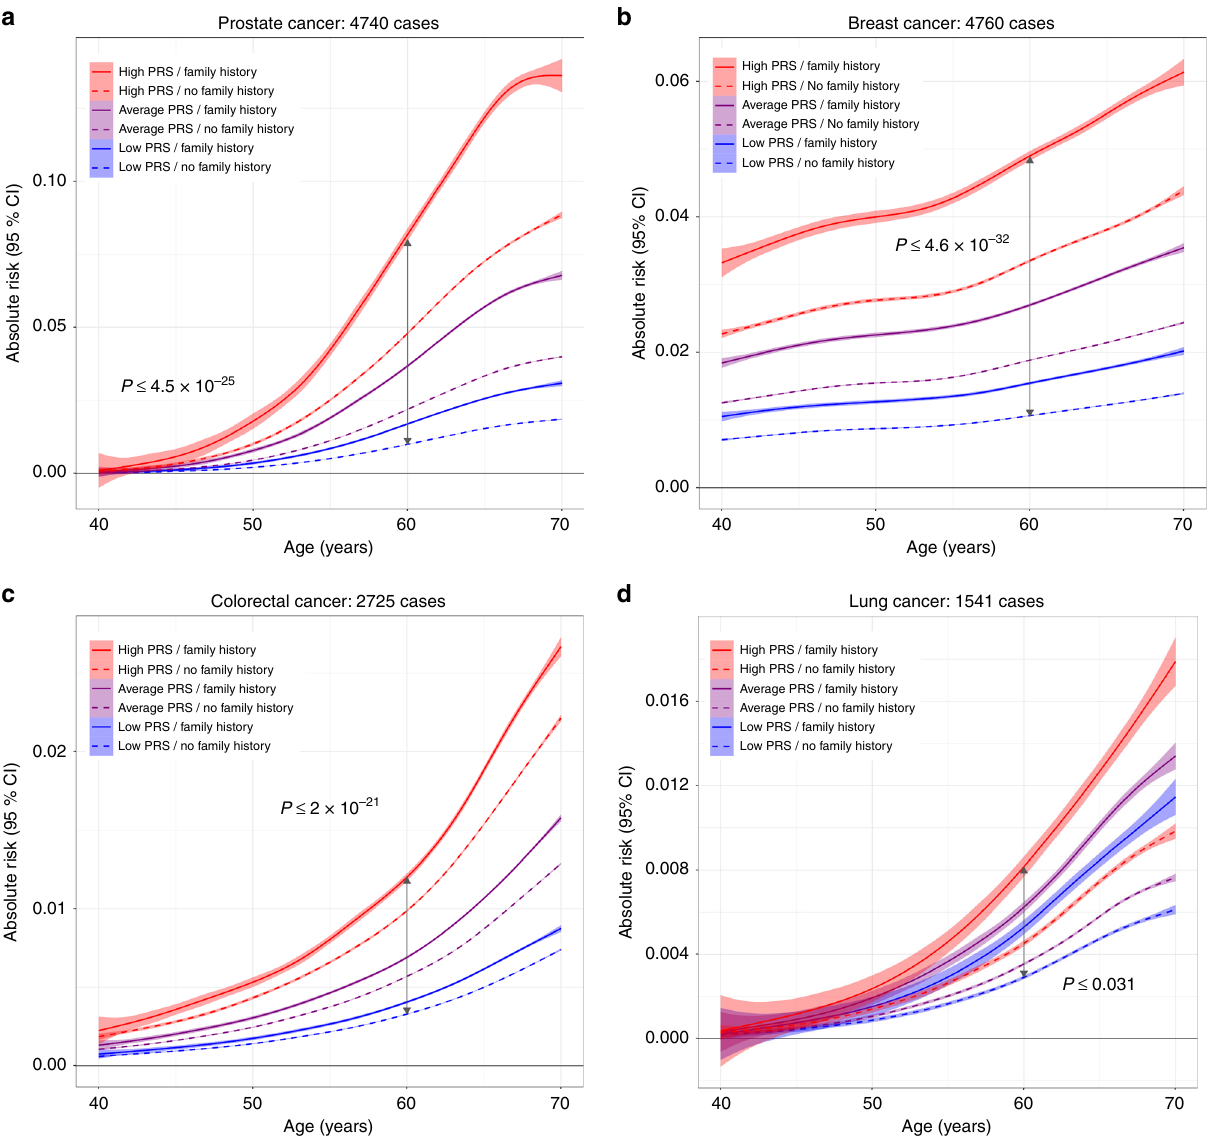
Fig. 3 Predicted 5-year absolute risk trajectories across strata de fi ned by family history and percentiles of the polygenic risk score (PRS) distribution. Family history was based on self-reported illnesses in fi rst-degree relatives for a prostate, b breast, c colorectal, and d lung cancers. Low PRS corresponds to ≤ 20th percentile, average PRS is de fi ned as >20th to <80th percentile, and high PRS includes individuals in the ≥ 80th percentile of the normalized genetic risk score distribution. P values for differences in mean absolute risk in each stratum at age 60 are based on t -tests (two